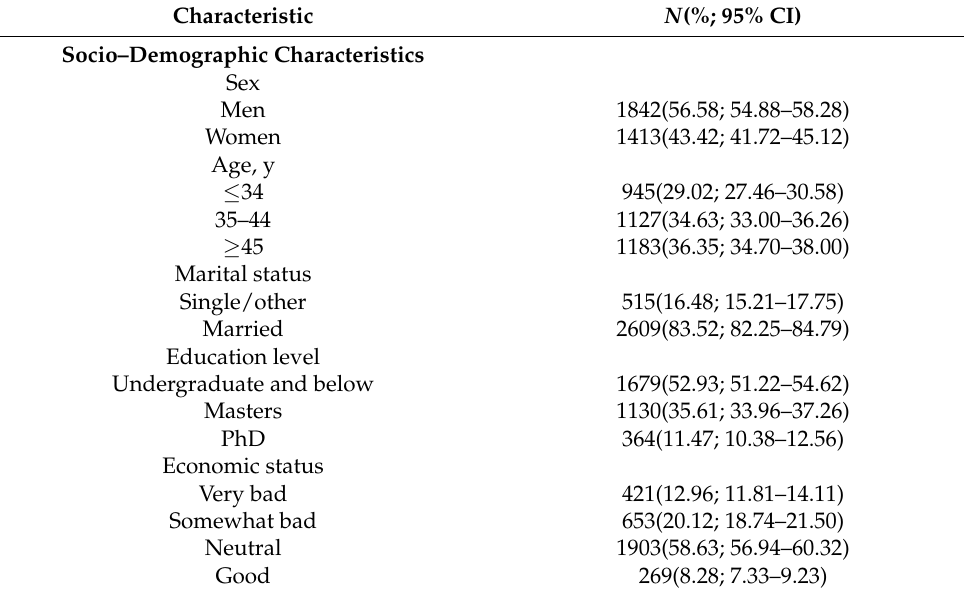
Table 1. Sociodemographic characteristics of